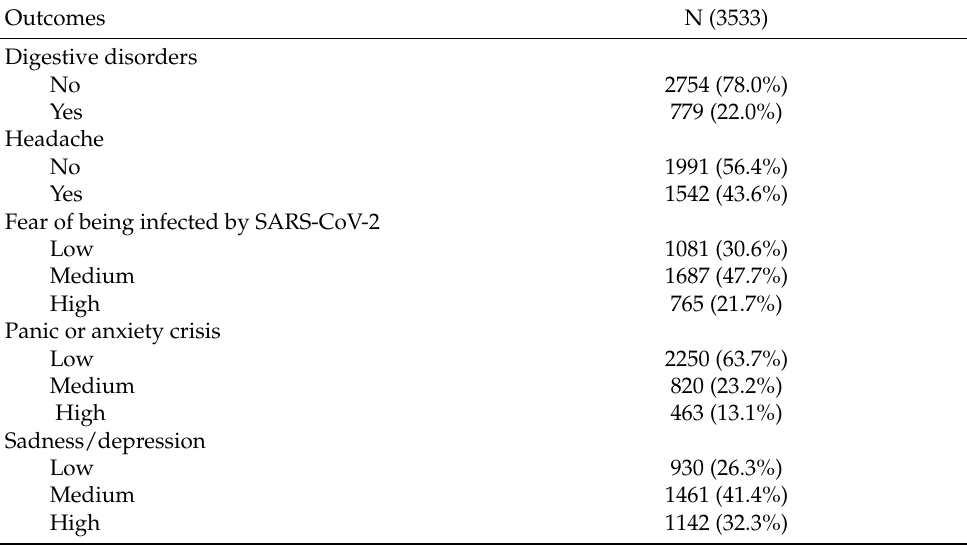
Table 2. Descriptive statistics of the overall 3533 participants in the survey for the outcome